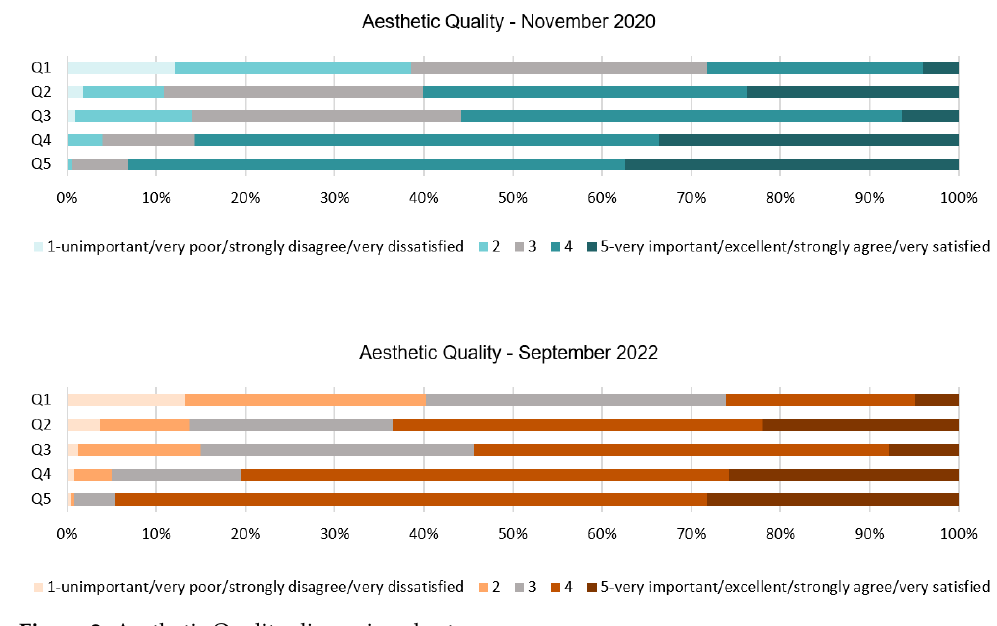
Figure 2. Aesthetic Quality dimension chart.